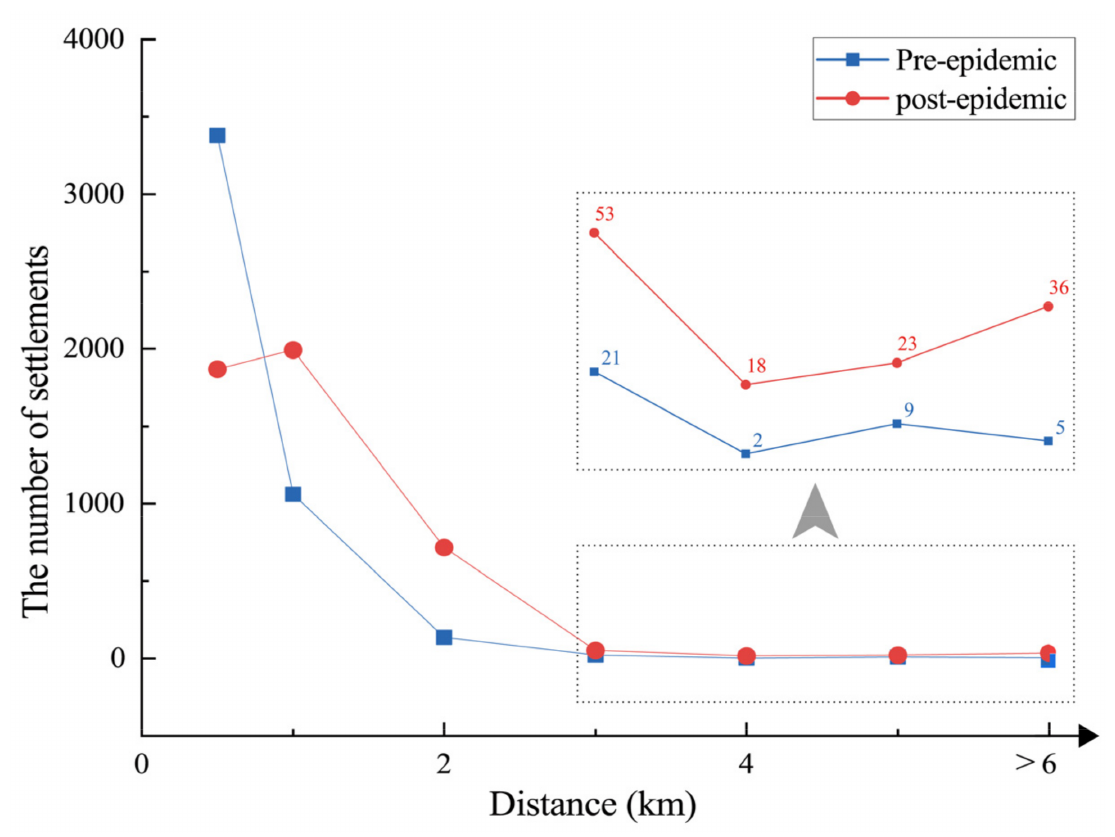
Figure 11. The number of settlements to the nearest outdoor sports venue for different buffer